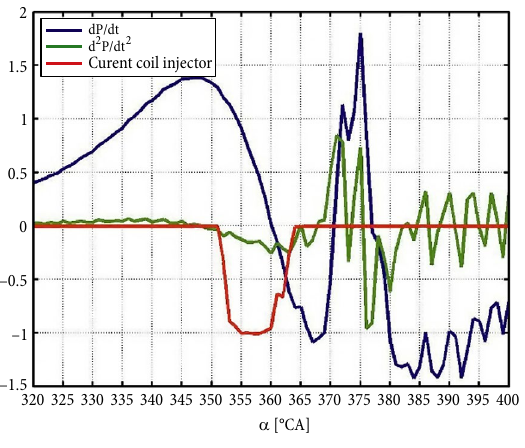
Fig. 12. A juxtaposition of the first and second derivative Fig. 11. A juxtaposition of the first and second derivative of of pressure in the combustion chamber with injector control pressure in the combustion chamber with injector control current; n = 1500 rpm; T = 50 Nm; U DO = 80% current; n = 3400 rpm; T = 100 Nm; U DO = 80% (undivided (divided dose of diesel oil) dose of diesel oil) Table 2. Characteristic parameters of injection of diesel oil and the process of combustion for selected measurement points n [rpm] T